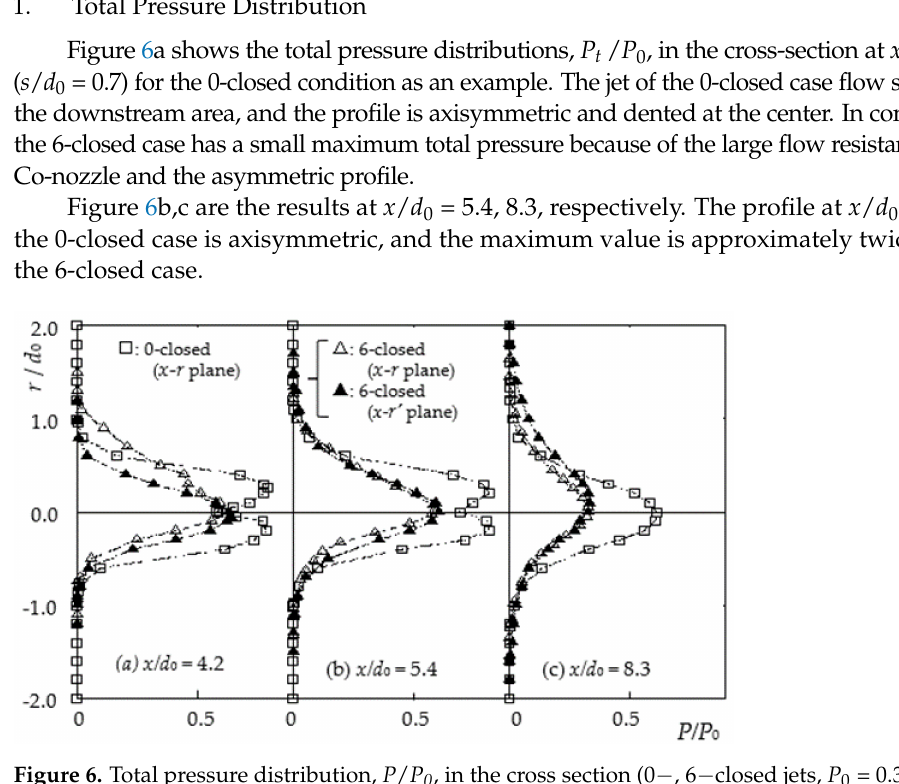
Figure 6. Total pressure distribution, P / P 0 , in the cross section (0 − , 6 − closed jets, P 0 = 0.380